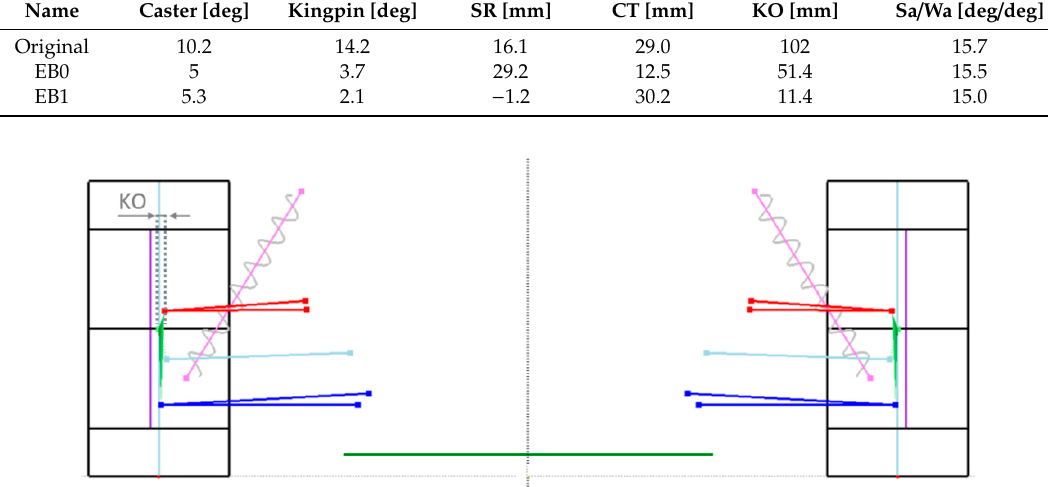
Figure 16. Schematic front view (yz plane) of the EB1 suspension, KO has been reduced to almost zero. After the same sine steer sweep test, the steering wheel torque of EB1 is shown in blue in Figure 17. Apart from a small phase shift at low frequency, the steering e ff ort is very similar to the reference case.